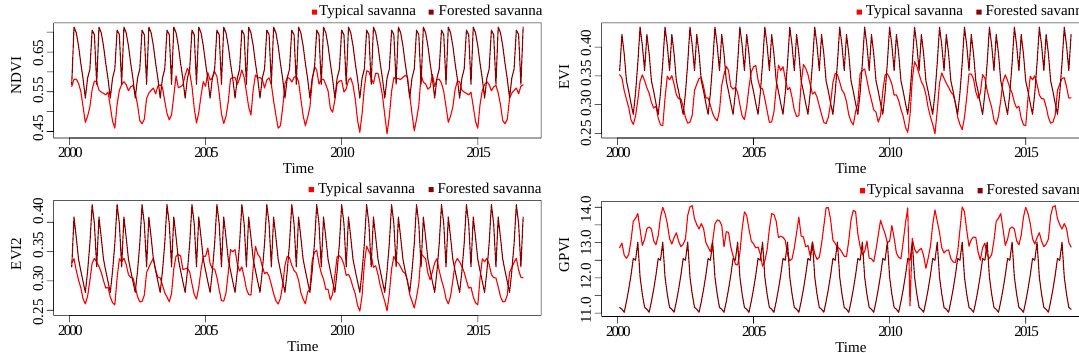
Figure 12. Time series for typical savanna/forested savanna discrimination (Landsat).